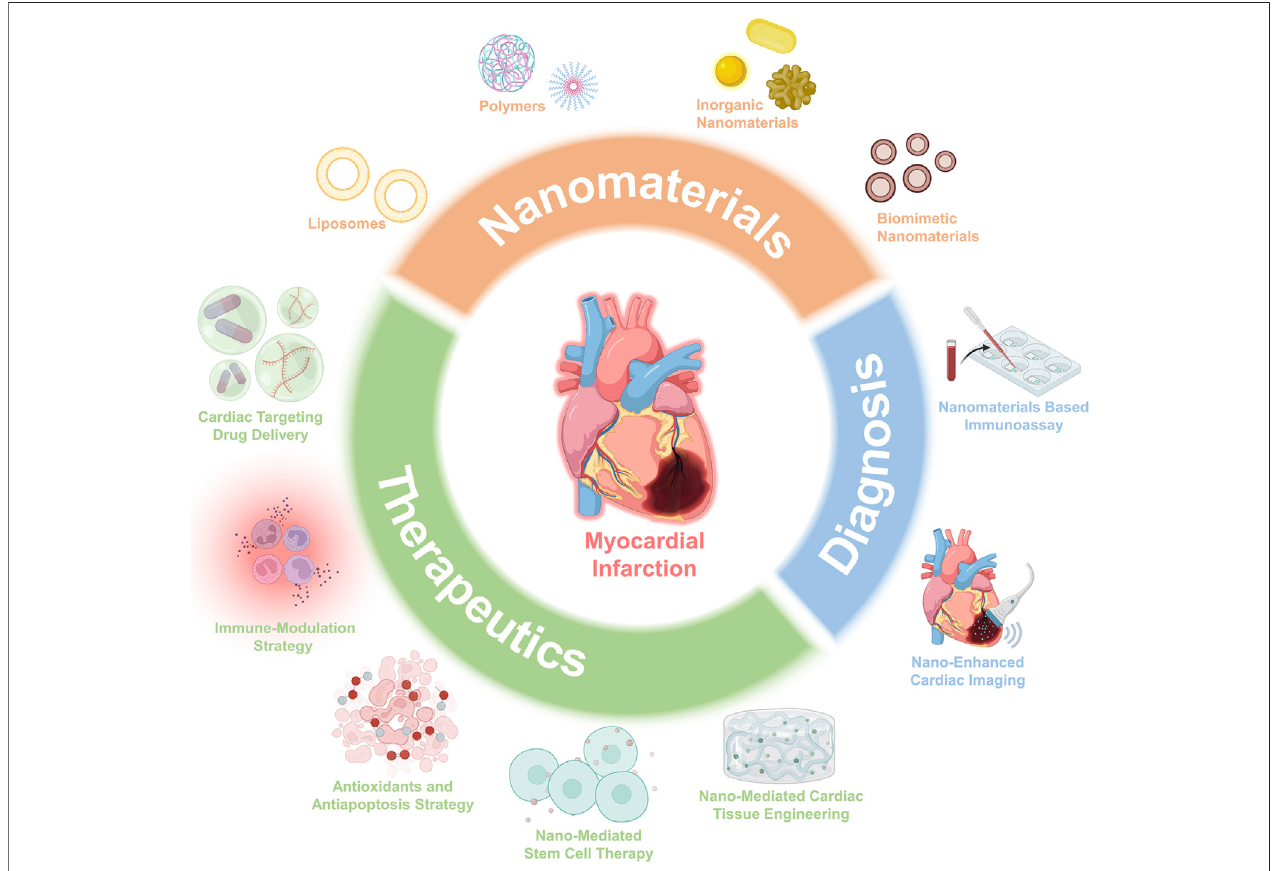
FIGURE 1 | Schematic overview of the advances of nanomaterials and applications for both therapeutics and diagnosis.